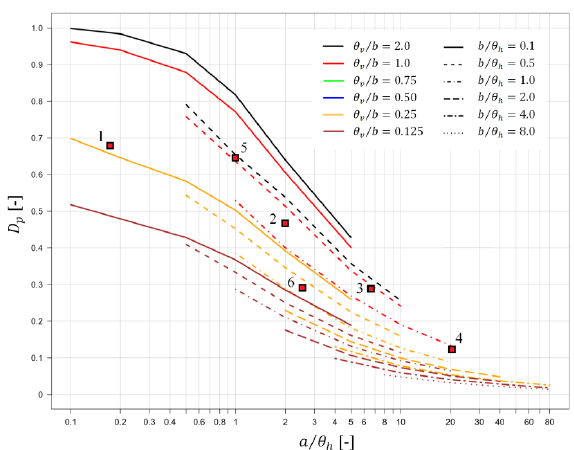
⁄ b and the line type (coloured on black in v ⁄ b v